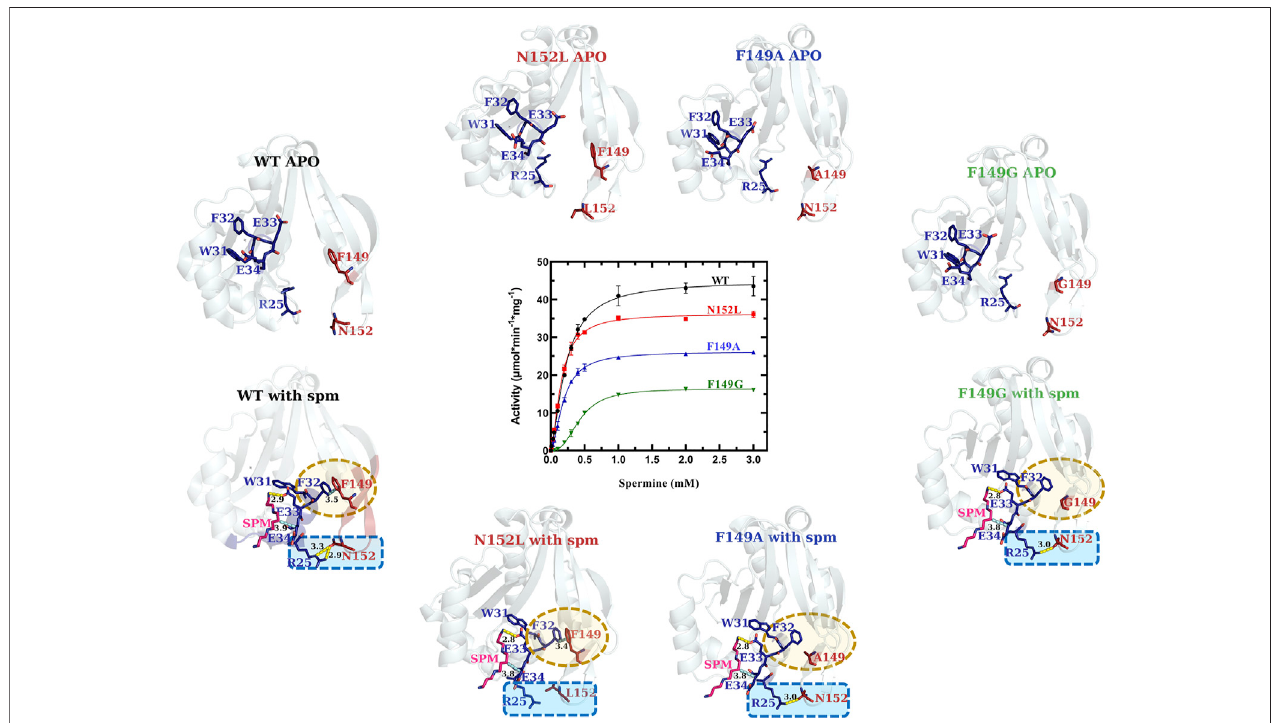
FIGURE 6 | Comparison of kinetic activity and structures/models of Region 3 point-mutants (R3C4-R3C6). Crystal structures of apo-WT, R3C4 (N152L), R3C5 (F149A), and R3C6 (F149G) are shown along the top of the substrate saturation kinetic plot, whereas homology models of R3C4-R3C6 constructs based on the spm- bound WT crystal structure (PDB ID: 4mi4) are along the bottom. Regions of variability are highlighted in yellow and blue dotted shapes. H-bonds are shown as dashed yellow lines. Speci fi c residues of interest are shown as sticks and